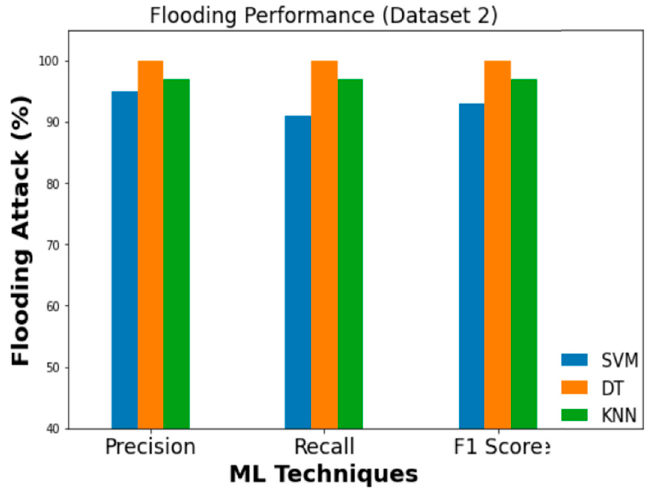
Figure 19. Performance evaluation metrics (flooding).